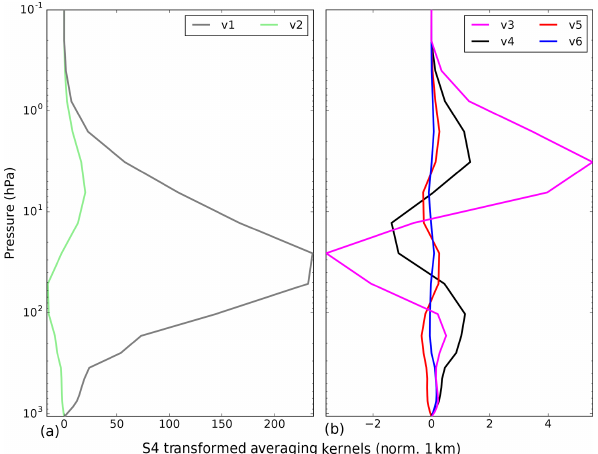
Figure 4. S4 ozone retrieval mean transformed averaging kernel for summer 2003 over the European domain for the first six leading eigenvectors. (a) v 1 (grey line) and v 2 (green line). (b) v 3 (magenta line), v 4 (black line), v 5 (red line), and v 6 (blue line). Note that the x axis scale changes between the two panels, and the AKs are normalized to 1km by dividing them by the dz (difference between the top and bottom heights of the layer) corresponding to each